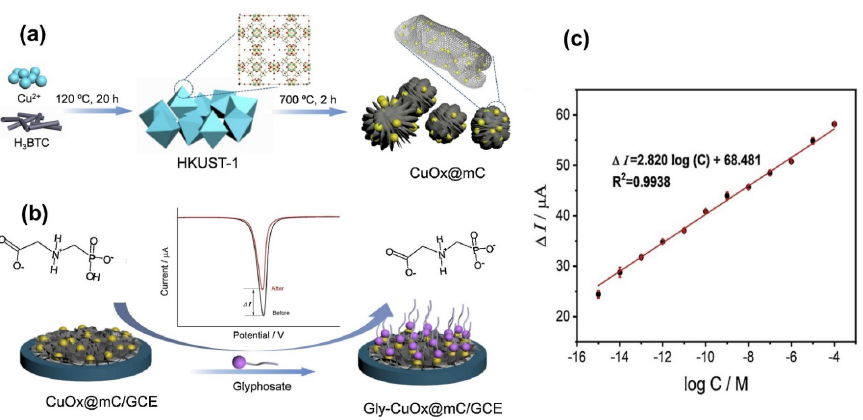
Figure 23. Nanocomposite development for an electrochemical sensor. ( a ) CuOx@mC composite formation, ( b ) Analytical principle of the electrochemical sensor based on the CuOx@mC composite, ( c ) A calibration curves between ΔI and the GLYP concentrations for CuOx@ m C GCE. Reprinted with permission from [198]. Copyright 2020 Elsevier.